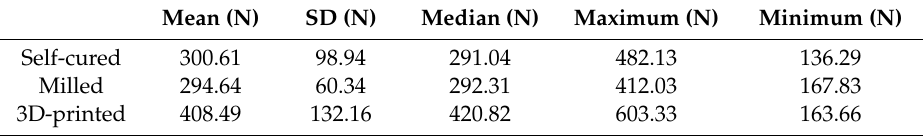
Table 2. Descriptive statistics of force at provisional fixed dental prosthesis